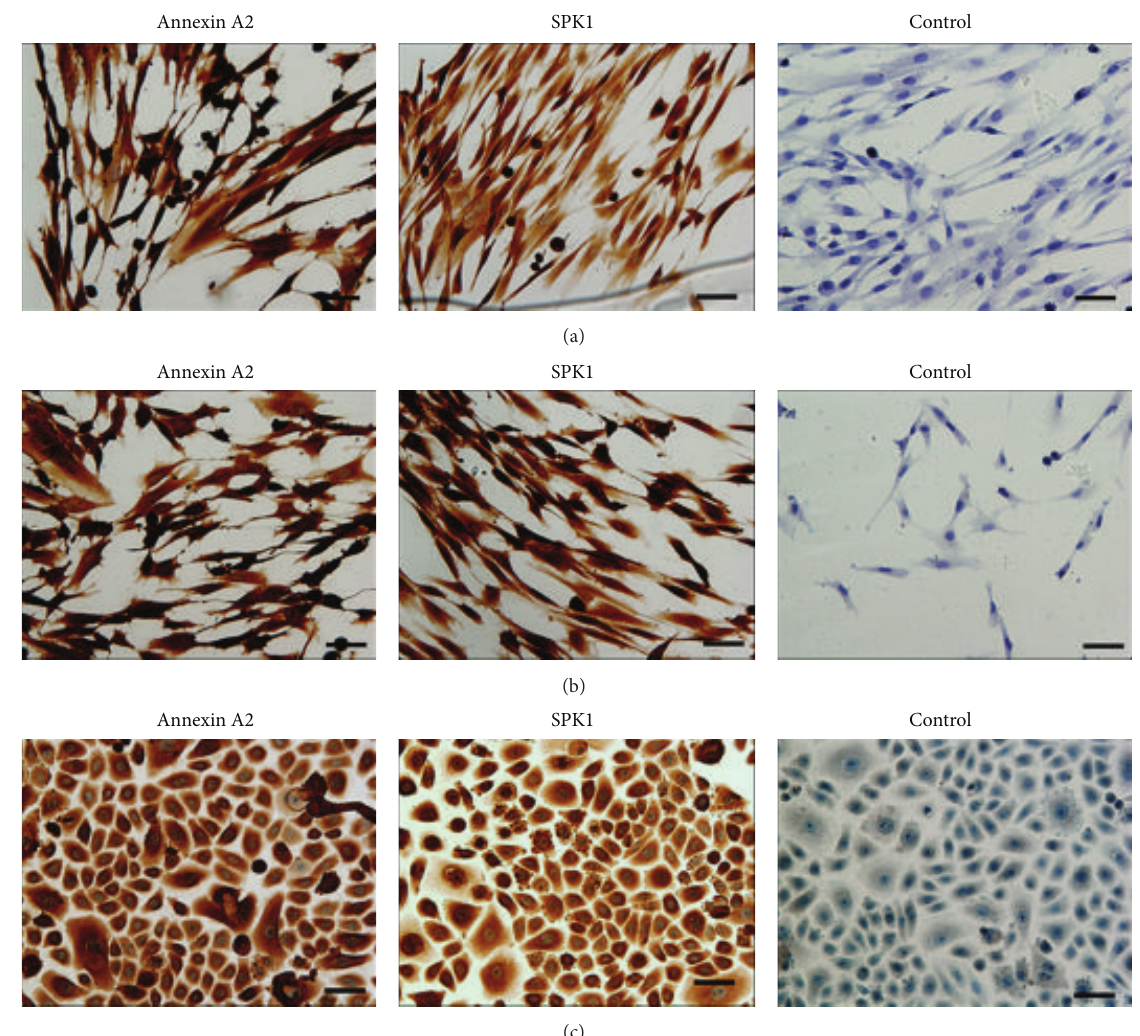
Figure 3: The expression of Annexin A2 and sphingosine kinase 1 (SPK1) in fixed and permeabilized (a) human periodontal ligament stem cells (PDLSC), (b) gingival fibroblasts (GF), and (c) keratinocytes using immunohistochemistry. All cell types studied were positive to anti- Annexin A2 and anti-SPK1 antibodies. Scale bar = 50 𝜇